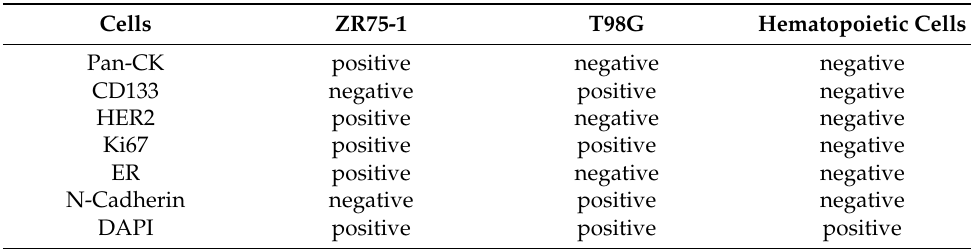
Table 2. Immunofluorescent staining of cell lines ZR75-1 and T98G as well as hematopoietic bone marrow cells for the six different markers used.